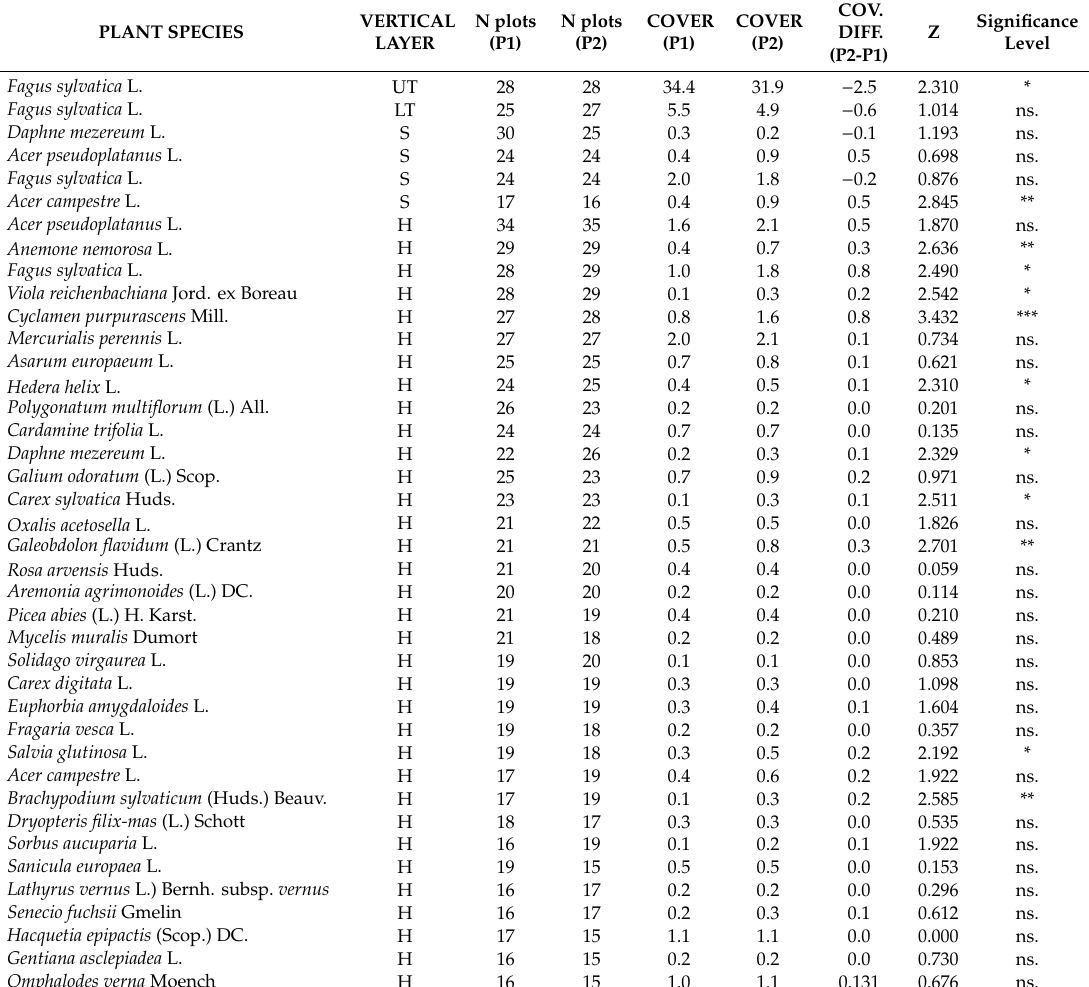
COV. VERTICAL N plots N plots COVER COVER DIFF. LAYER (P1) (P2) (P1) (P2)